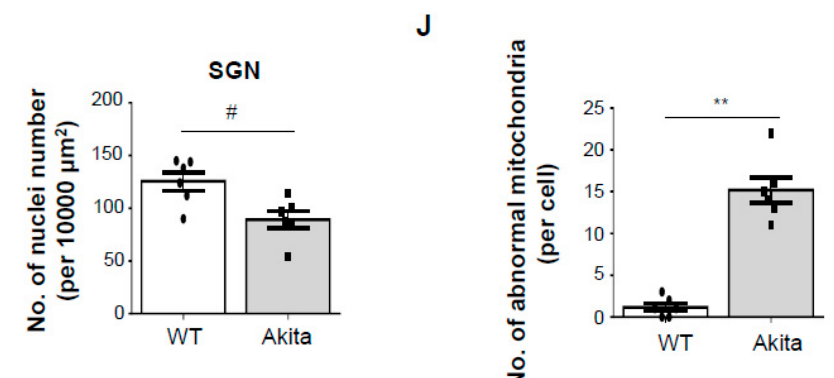
Figure 2. Histopathological analysis of the organ of Corti (OC) and spiral ganglion neurons (SGNs). ( A , B ) H&E staining of WT and Akita cochleae. Whole cochleae (scale bar, 250 µ m), ( C , E ) OCs (scale bar, 30 µ m), and ( D , F ) SGNs in the middle turn of the cochlea (scale bar, 10 µ m). The black arrowheads indicate inner hair cells (IHCs) and outer hair cells (OHCs); the loss of SGNs is indicated by a red arrow. ( G , H ) Transmission electron micrograph (TEM) of SGNs in the middle turns of WT and Akita cochleae. Red boxes are zoom-ins showing mitochondria morphology. Abnormal mitochondria shapes (red arrows) can frequently be seen in the Akita group compared to WT. Scale bar, 2 µ m. ( I ) Quantification of the number of SGNs in the middle turns of the cochlea. The average number of SGNs per 10,000 µ m 2 in the middle turns of cochlea tissue from WT and Akita mice. Individual squares or circles represent individual mice ( n = 6 for each group). ( J ) The numbers of abnormal mitochondria between WT and Akita mice were quantified using Image J ( n = 6 images / group). Results are means ± SEM. # p < 0.05 and ** p < 0.01 by Student’s t -test.